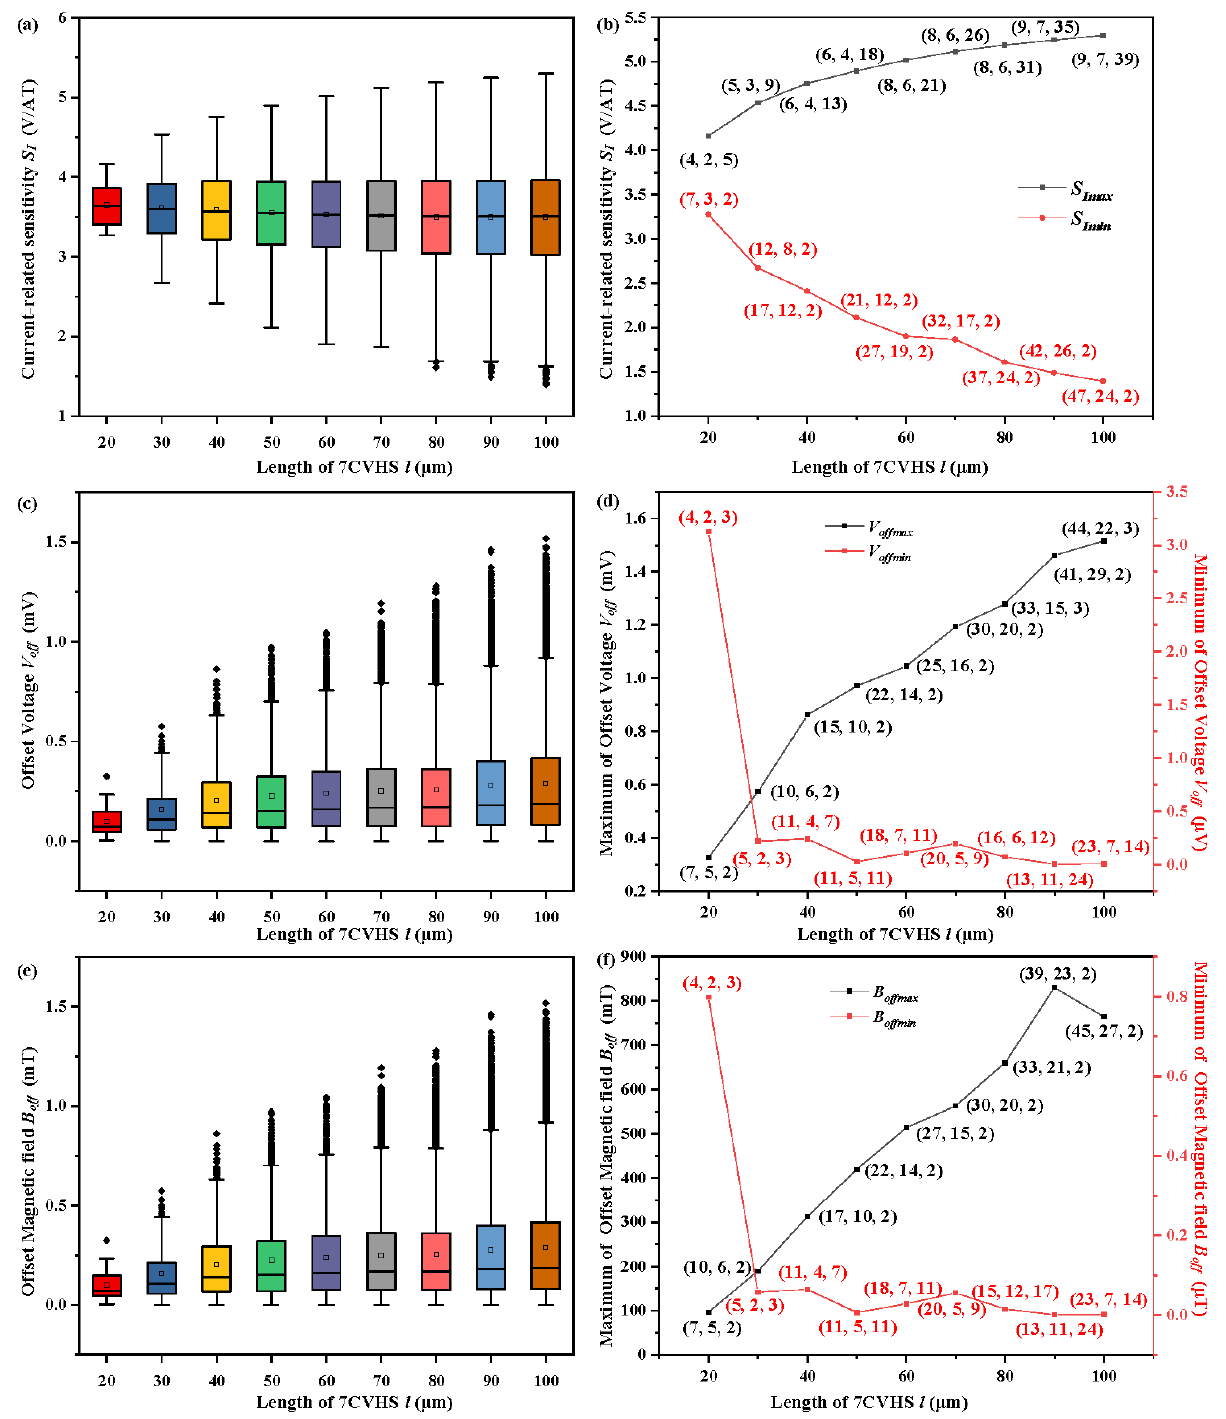
Figure 4. Current-related sensitivity S I ( a ), offset voltage V off ( c ), and offset magnetic field B off ( e ) of various lengths of the 7CVHS from 20 to 100 µ m illustrated by boxplots. Maximum and minimum values of current-related sensitivity S Imax and S Imin ( b ), offset voltage V offmax and V offmin ( d ), and offset magnetic field B offmax and B offmin ( f ) in various lengths of the 7CVHS from 20 to 100 µ m extracted from ( a , c , d ),